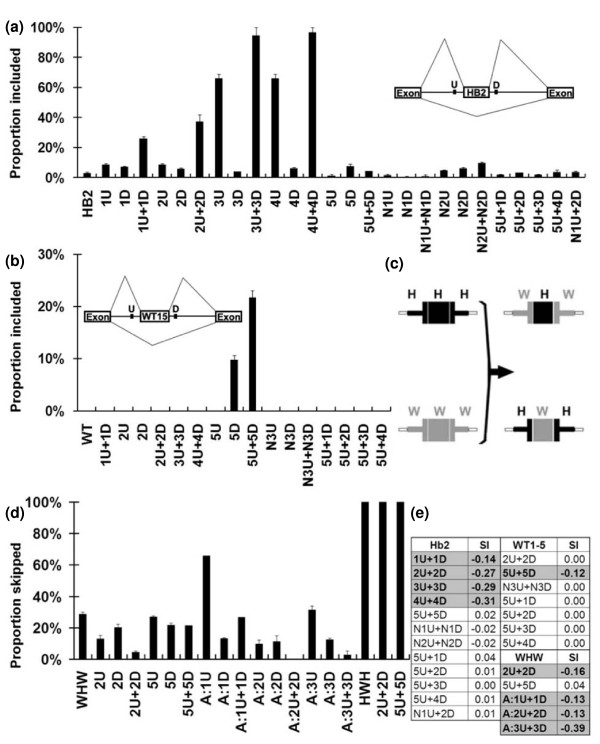
Co-occurring pairs act synergistically to promote splicing. (a) Splicing of Hb2 exons in transient transfection experiments. The inset diagram is a schematic view of the minigene used. The central exon used to gauge inclusion was exon 2 of the human beta globin gene, including its splice site sequences. Five co-occurring pairs from the UpDp class were tested by inserting two tandem pentamers upstream and/or downstream of the exon. The pairs were: 1, TCCCT_GGAGG; 2, CCCCT_AGGGA; 3, TTTCT_TGGTG; 4, TTTCT_GGTGG; and 5, CGCCG_CGCGC. We also tested two neutral tandem pentamer motifs (N1 and N2) chosen not to resemble any known splicing motifs nor to create such by their insertion nor to create any significantly correlated motif pairs when inserted. U, upstream position; D, downstream position. (b) Splicing of WT1-5 exons (exon 5 of the Wilm's tumor gene 1). As (a) but with exon 5 of the Wilm's tumor gene as the central exon, and a different neutral control sequence, N3. (c) Diagram of the central exon region of exon body swapped minigenes. (d) Splicing of minigene transcripts with exon body swapped exons. Three co-occurring pairs from the UpDp class of alternative exon sets were also tested in this context. The three pairs were: A1, TGGGG:CTGGG; A2, CAGTG:CTTCT; A3, GGGCG:GCGCG. Note that splicing here is measured by percent skipping rather than inclusion. (e) Synergy index (SI) of tested pairs. A negative SI signifies synergy, a positive SI signifies anti-synergy and an SI of zero indicates a lack of synergy. Error bars are the standard error of the mean.